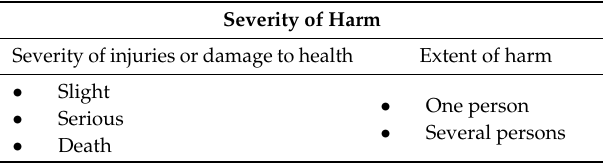
Table 4. Factors a ff ecting the severity of harm based on ISO 12100.